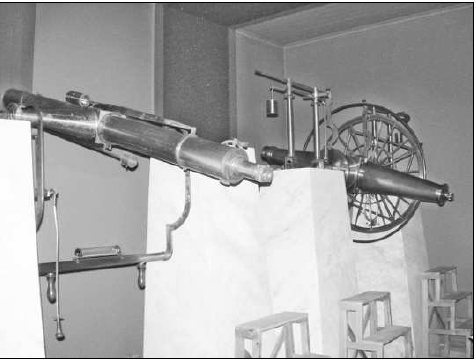
Fig. 3. The new meridian room in the west wing. Transit telescope by Reichenbach and Ertel from 1824 to the left and the transit circle by Ertel from 1830 to the right. Image: Michael